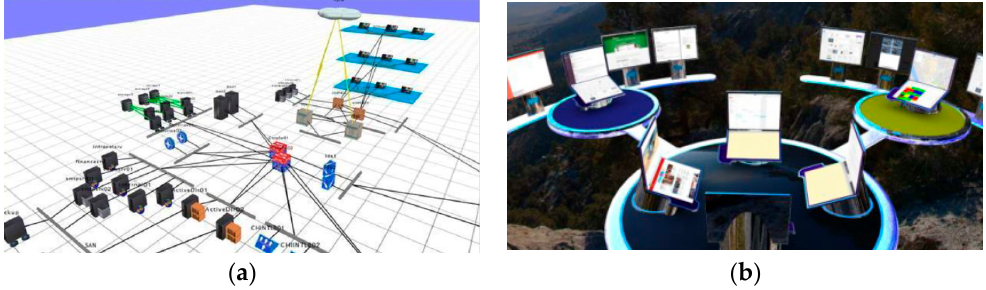
Figure 9. 3D representation of the workflow [31] ( a ) and MaxWhere 3D employees’ workspace [31] ( b